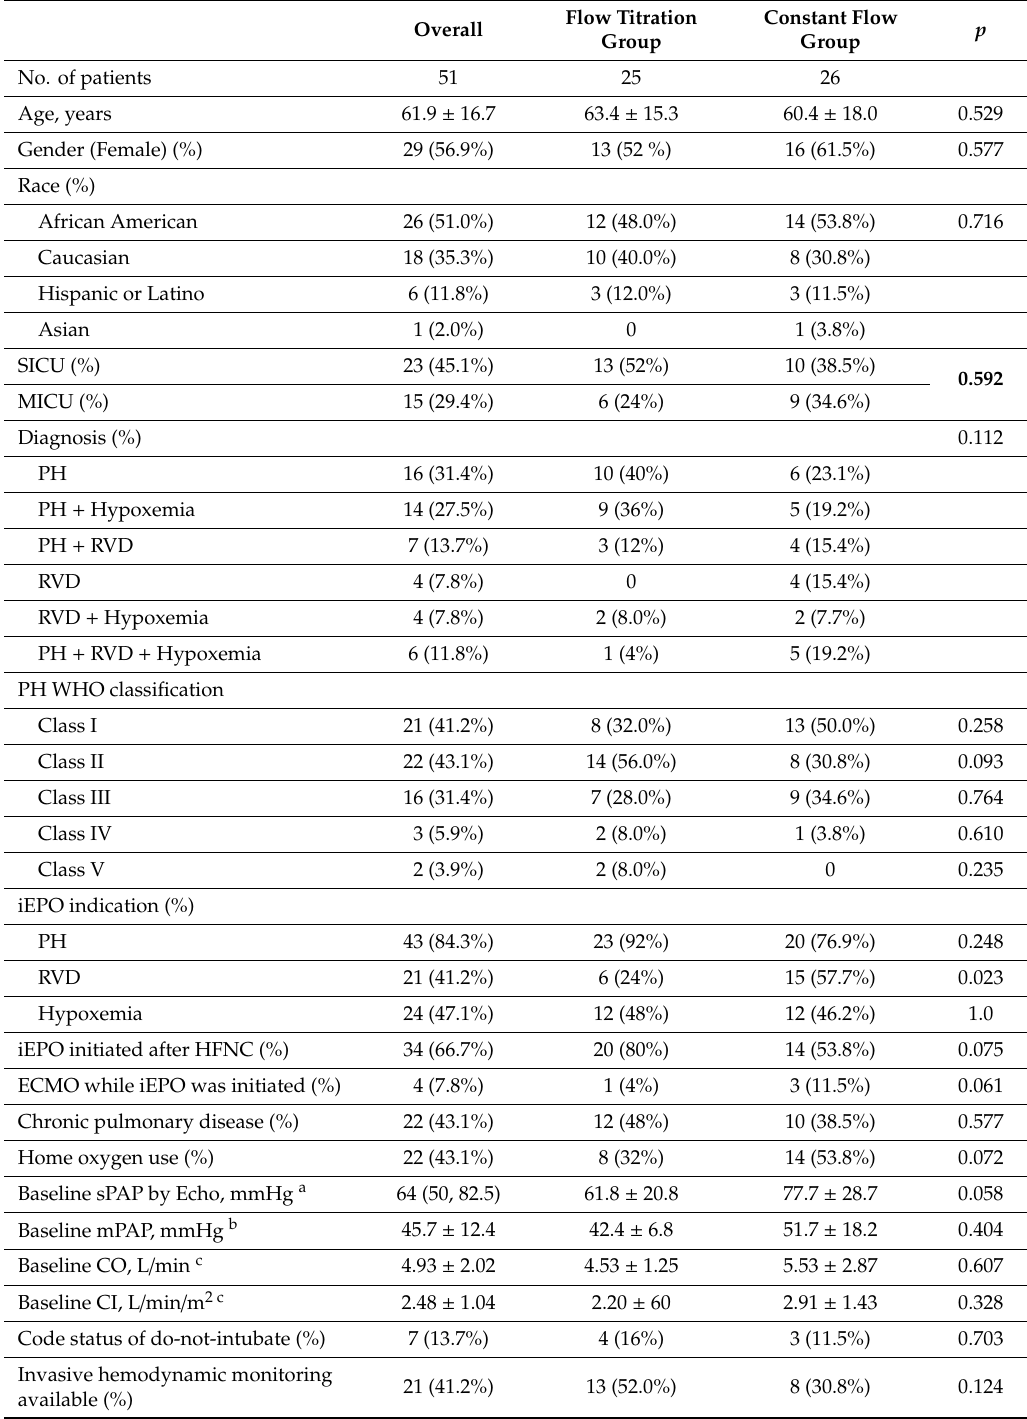
Table 1. Comparisons of demographic information for patients with flow titration and constant